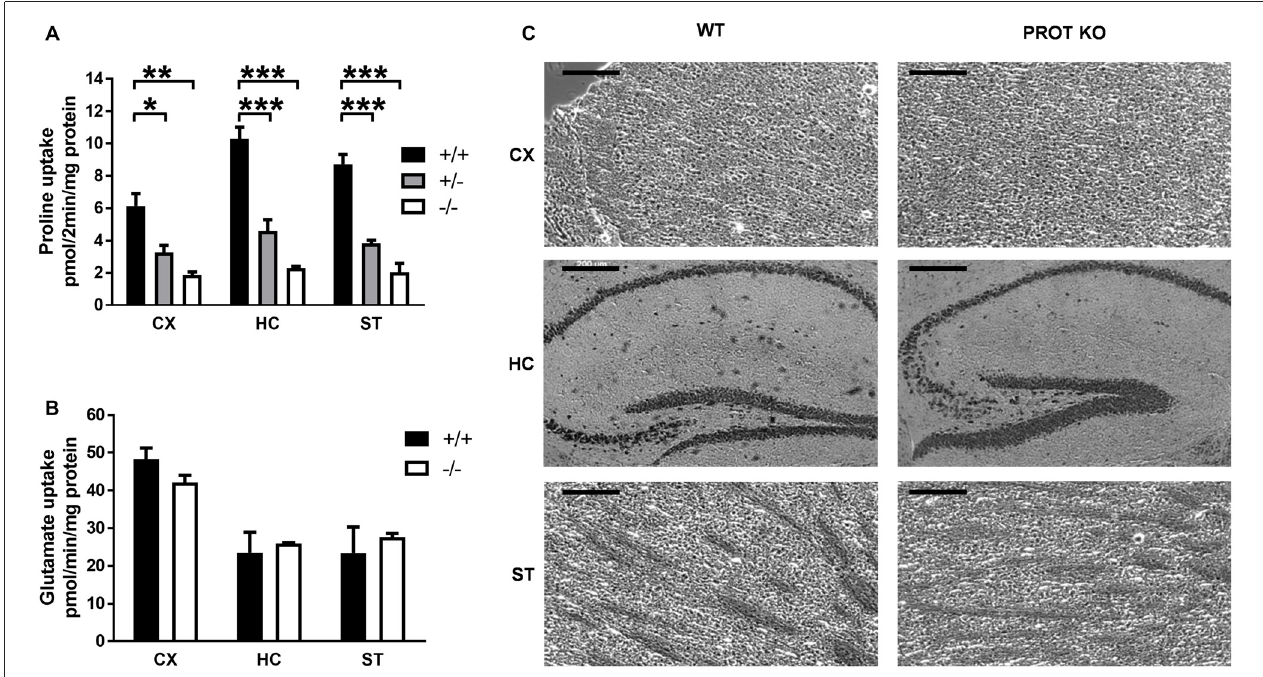
FIGURE 2 | L-Proline transport activity is reduced in PROT − / − mice. (A,B) Membranes were prepared from the indicated tissues of WT (+/+), heterozygous (+/ − ), and homozygous ( − / − ) KO mice, and then assayed for L-proline uptake for 2 min (A) or L-glutamate uptake for 1 min (B) at 37 ◦ C. (C) Cresyl violet-stained sections from WT and PROT KO mice are shown. No defects were detected in the homozygous mutants, and the overall anatomy appeared normal in all animals analyzed. CX, cortex; HC, hippocampus; ST, striatum. Data are shown as means ± SEM ( n = 3 for each genotype). (A) One-way analysis of variance (ANOVA) with Bonferroni’s post hoc test; (B) two-tailed Student’s t test; ∗ p < 0.05; ∗∗ p < 0.01; ∗∗∗ p < 0.001. Scale bars: 200 µ